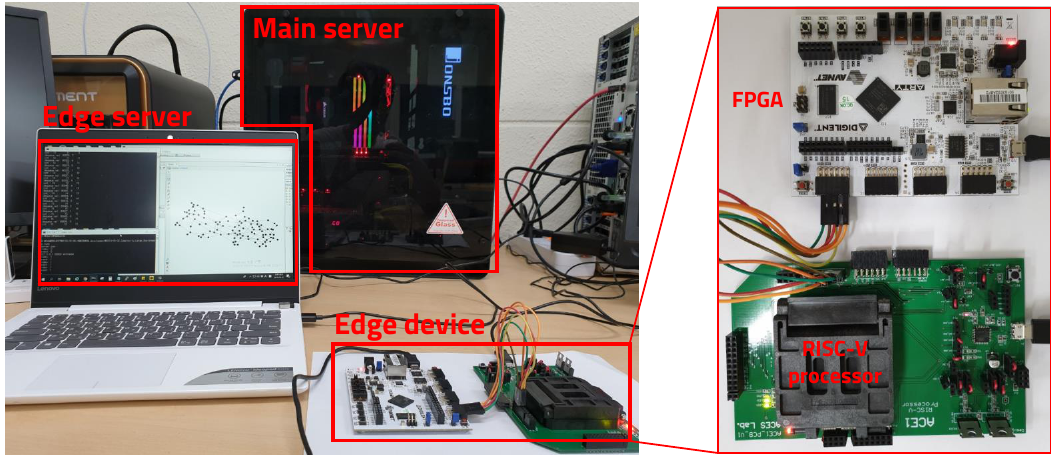
Figure 13. Experiment environment.